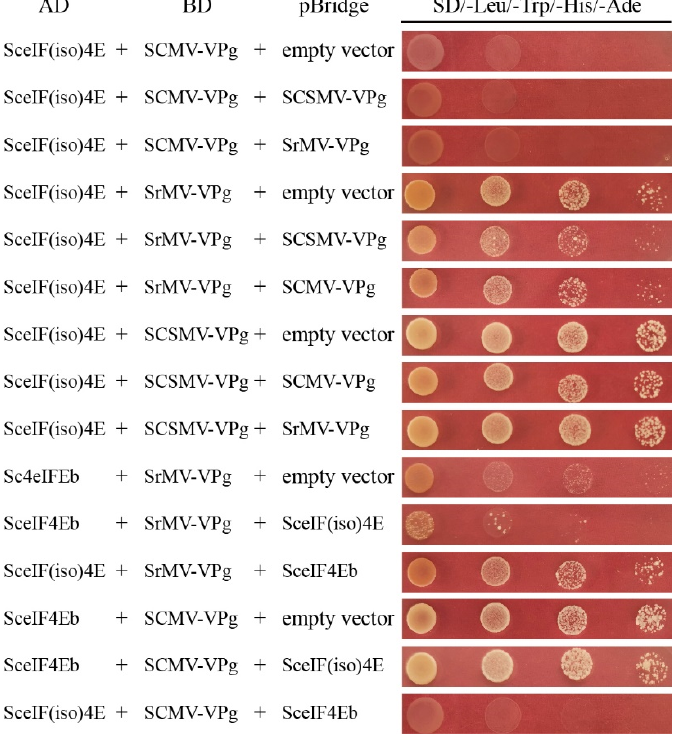
Figure 7. Competitive yeast two-hybrid assays. SCMV-VPg, SrMV-VPg, SCSMV-VPg, eIF4Eb, eIF(iso)4E were used as the competitor to test the interaction of SCMV-VPg, SrMV-VPg, SCSMV-VPg with eIF4Eb, eIF(iso)4E, respectively. The competitor was co-transformed with the paired interacting proteins fused with the activation domain (AD) or DNA-binding domain (BD) into the yeast AH109 cells in a 10 × dilution series of 10- µ L aliquots, which were then plated on the quadruple dropout medium SD/-Leu/-Trp/-His/-Ade.